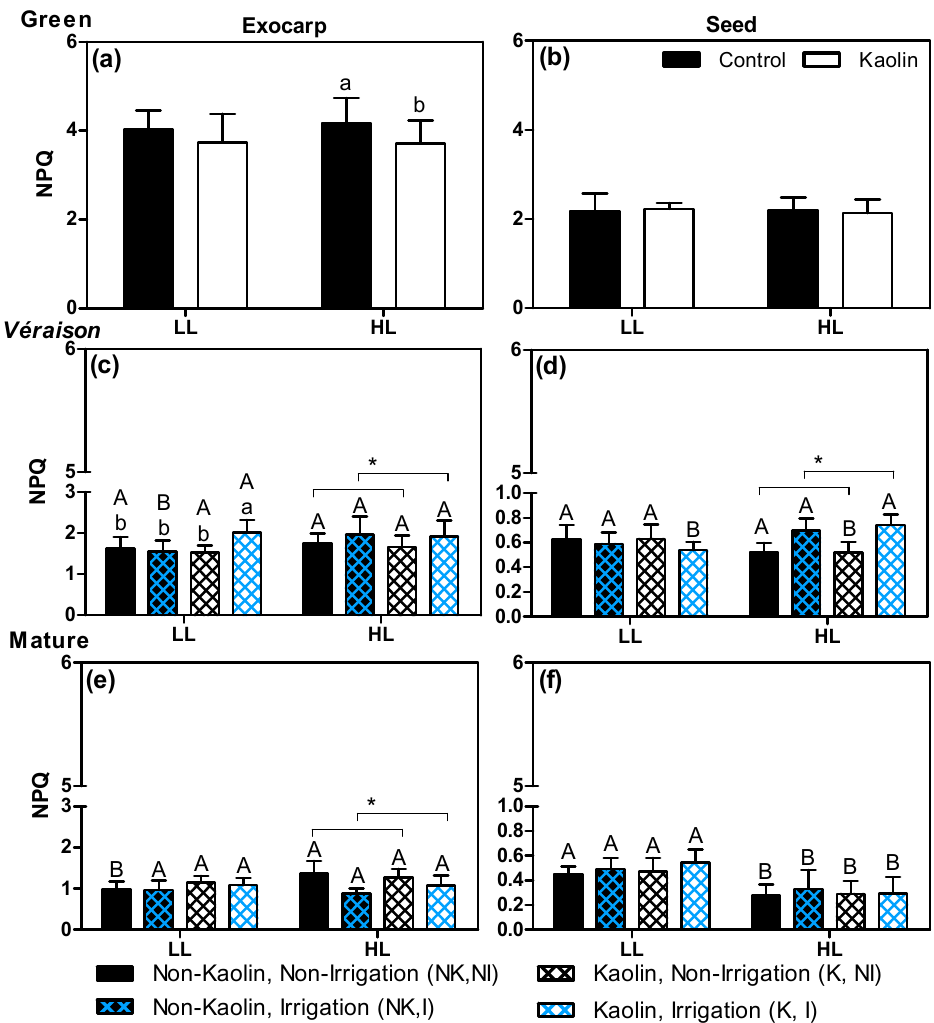
Figure 7. Non-photochemical quenching (NPQ) mean values ( n = 12–24 berries, +SD). All the microclimate conditions, treatment combinations, and statistical information are the same as in Figure 5.